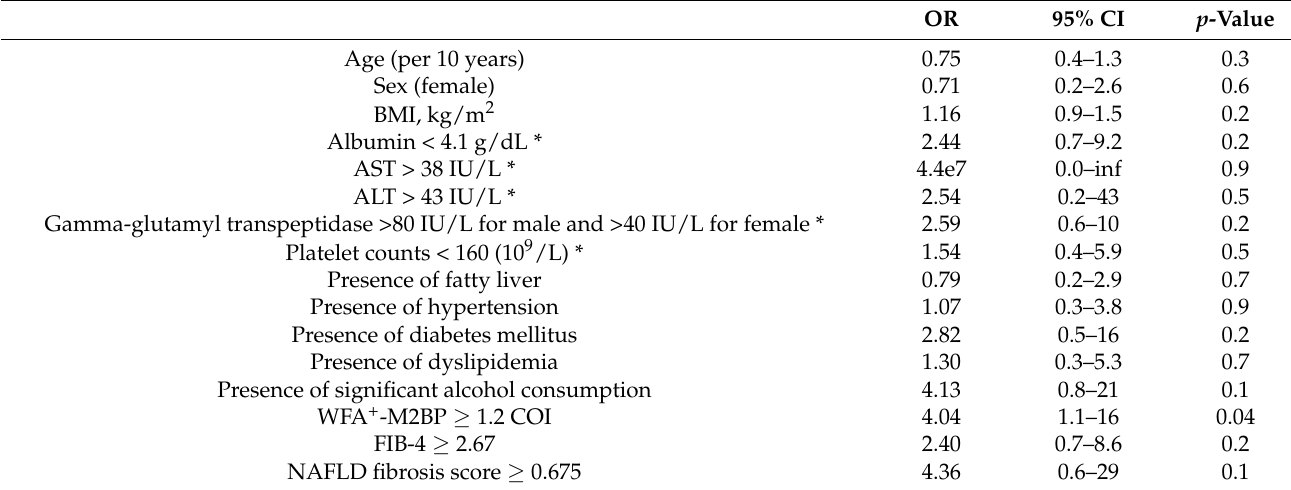
Table 3. Factors associated with significant